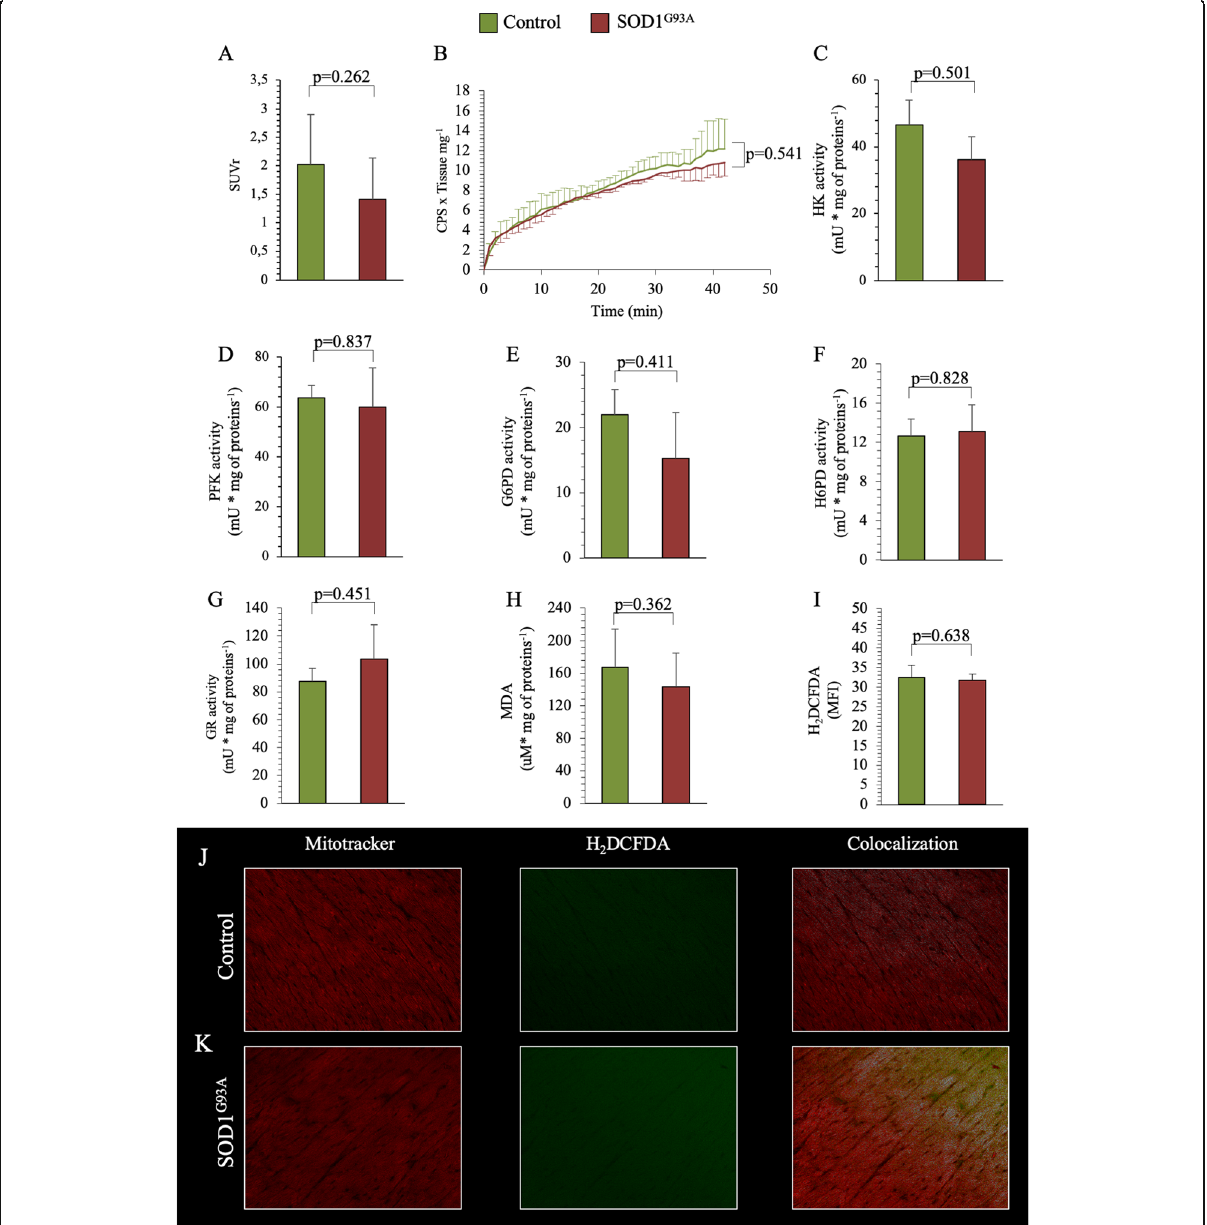
Fig. 6 Evaluation of glucose metabolism and redox status in the cardiac myocardium of SOD1 G93A and control mice. a Average of FDG retention expressed as standardized uptake value ratio (SUVr) in control (green column) and SOD1 G93A myocardium (red column). Data are expressed as mean ± SD, n = 5 for each group. b Average time-course of “ ex-vivo ” radioactivity expressed as a fraction of the FDG dose, measured by the Ligand-Tracer White® apparatus, in myocardium harvested from control (green line) and SOD1 G93A mice (red line). c – f Myocardial catalytic activities of HK, PFK, G6PD, H6PD, and GR ( g ) in control (green column) and SOD1 G93A (red column). h MDA levels and i MFI H 2 DCFDA in control and SOD1 G93A experimental groups. j , k Immunofluorescence representative images of Mitotracker® (as specific mitochondria staining — red fluorescence), H 2 DCFDA (as specific ROS staining — green fluorescence), and colocalization staining signals, in control and SOD1 G93A myocardium. Data are expressed as mean ± SD, n = 3 for each group. Student t test for unpaired data was used for statistical